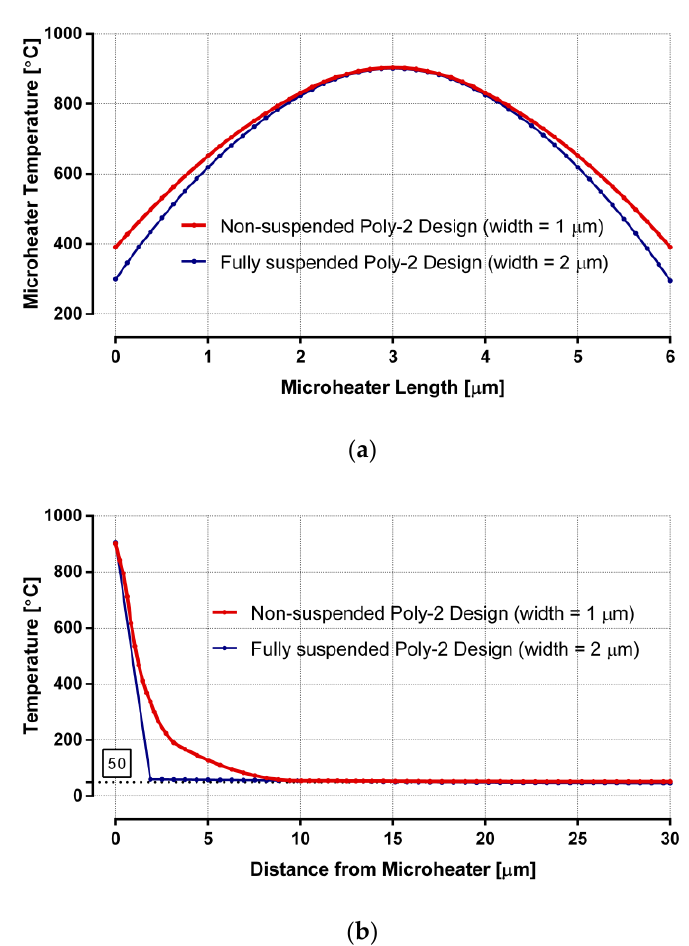
Figure 6. Thermal analysis of non-suspended and fully suspended poly-2 designs: ( a ) microheater temperature along its length; ( b ) temperature distribution from the center of the heater to the surrounding surface.